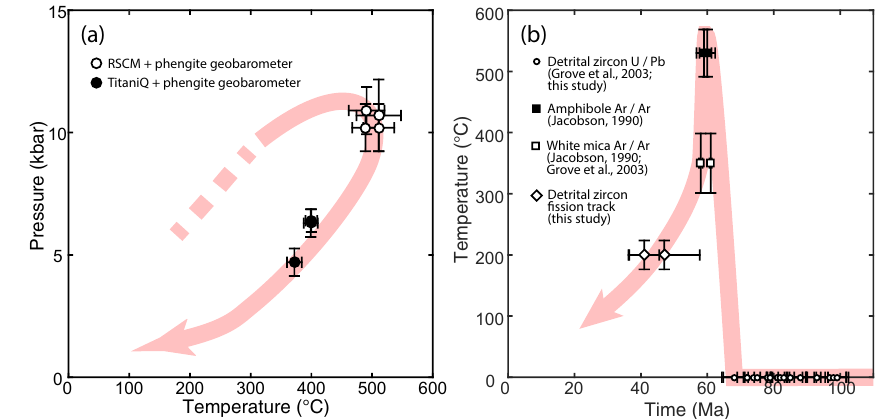
Figure 10. (a) P – T – t path and (b) thermal history of Pelona Schist. RSCM: Raman spectroscopy on carbonaceous material; TitaniQ: titanium-in-quartz